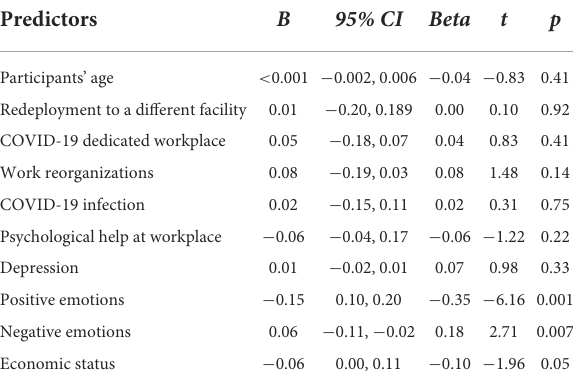
TABLE 4 Positive and negative emotions, depressive symptoms, and economic status as predictors of Disengagement.